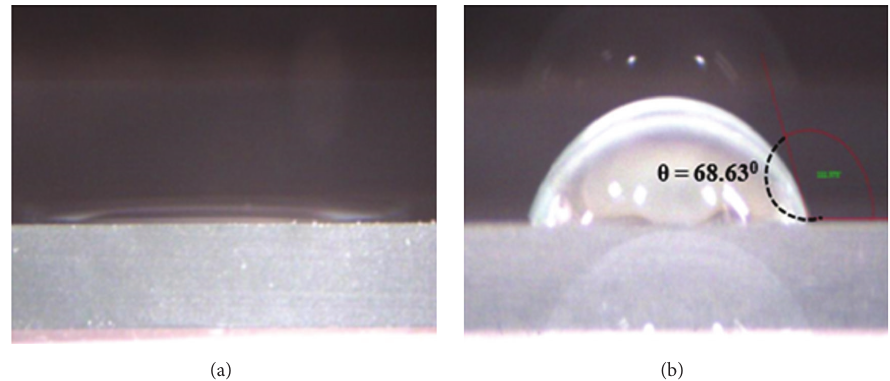
Figure 5: Contact angle comparison: (a) bare glass and (b) AMCA modified glass slide (adapted from